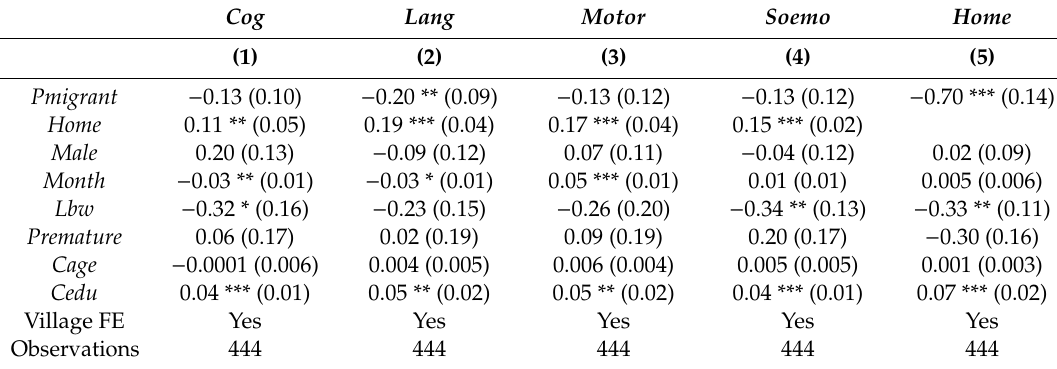
Table 2. Correlations between parental migration, home environment, and child